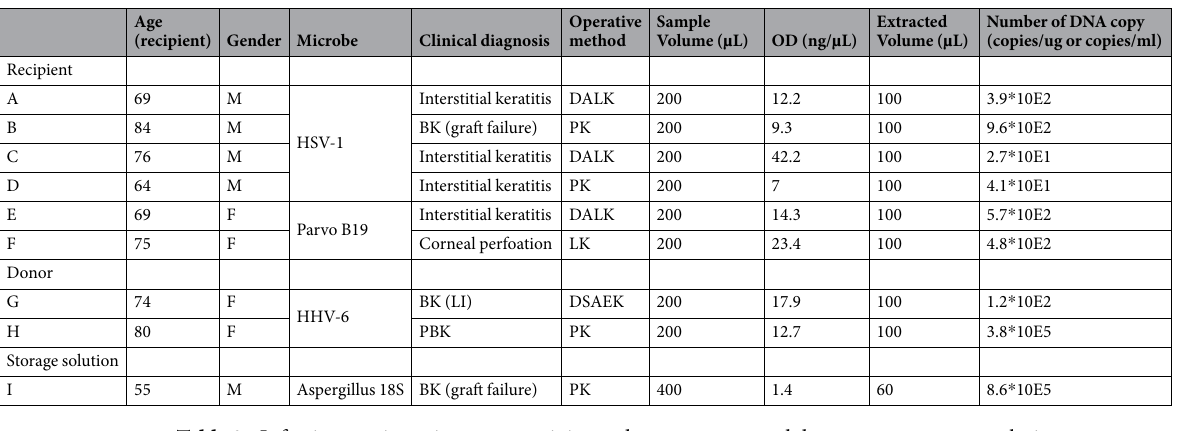
Table 2. Infectious antigens in cornea recipients, donor corneas, and donor cornea storage solution. BK = bullous keratopathy; DALK = deep anterior lamellar keratoplasty; DSAEK = Descemet’s stripping automated endothelial keratoplasty, HHV-6 = human herpes virus type 6 ; HSV-1 = human simplex virus type bullous keratopathy; PK = penetrating keratoplasty.